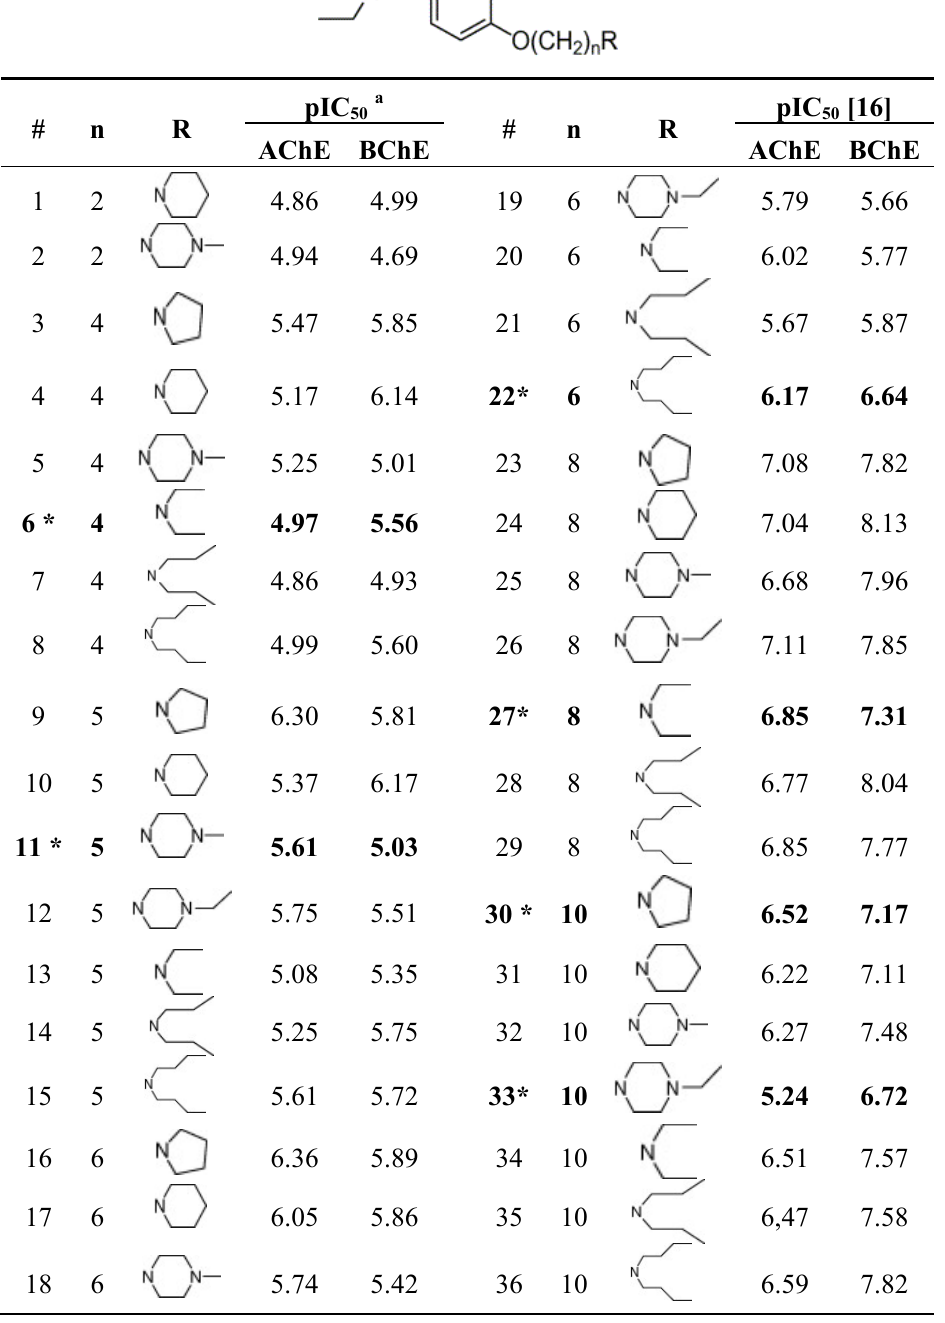
, M) of the AChE and BChE 50